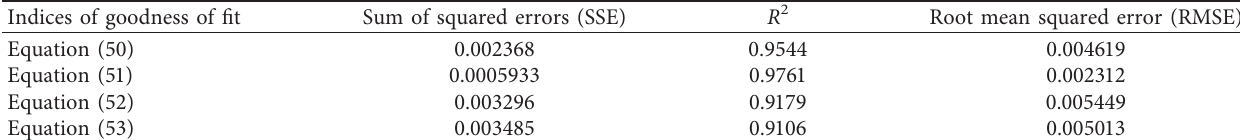
Table 10: Goodness of fit of equations.